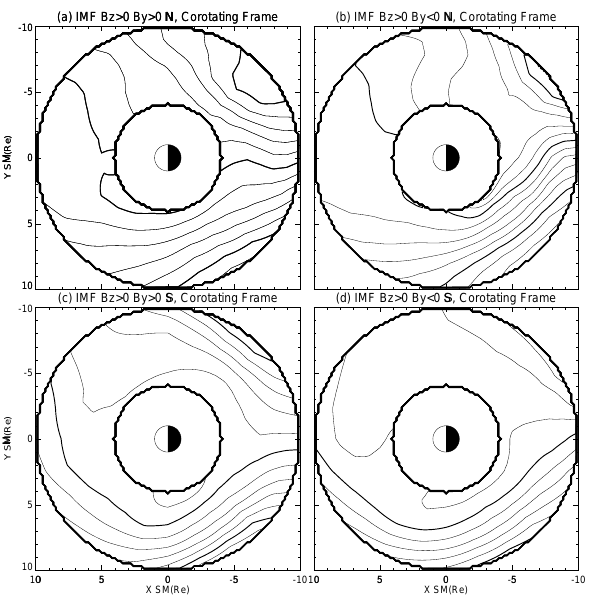
Fig. 4. Electric potential patterns at 4 <L< 10 for all MLT ranges. The conditions are IMF B Z ∼ 0 and indicated as follows for each panel: (a) IMF B Y > 0 in the Northern Hemisphere, (b) IMF B Y < 0 in the Northern Hemisphere, (c) IMF B Y > 0 in the Southern Hemi- sphere, (d) IMF B Y < 0 in the Southern Hemisphere. The patterns are shown in the corotating frame. The contour intervals are 2kV and 10kV for thin and thick lines,